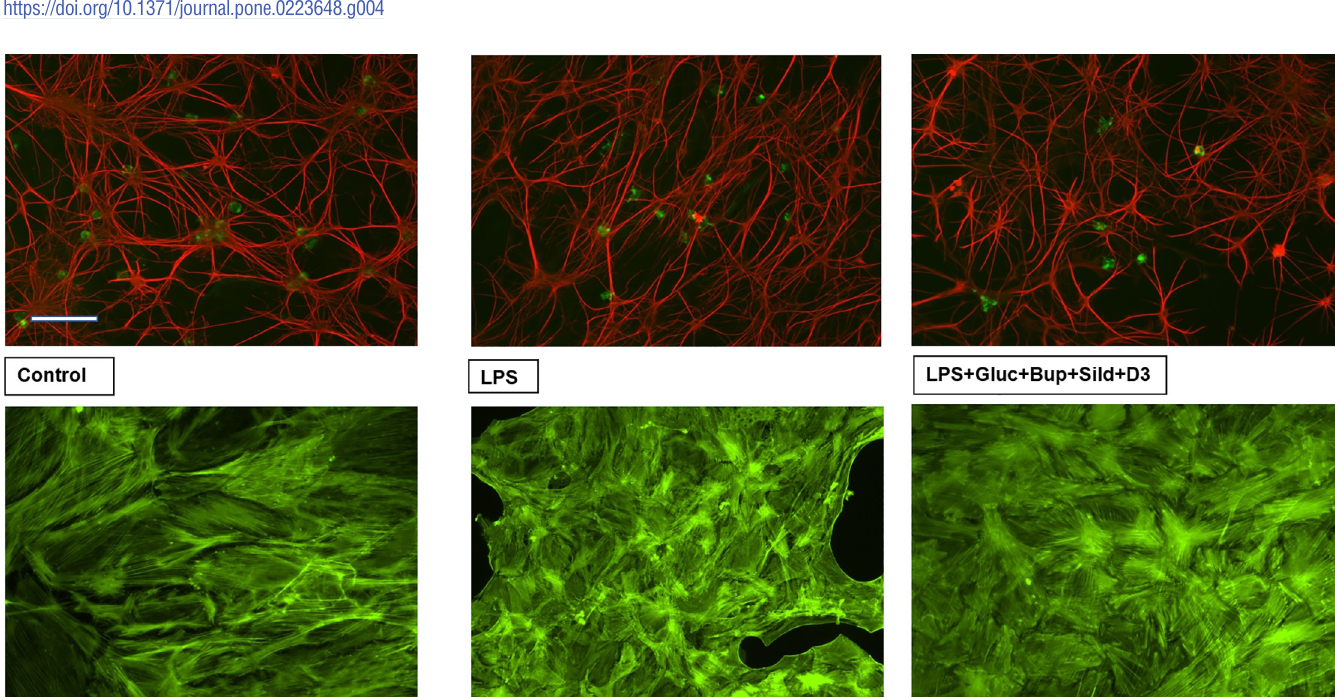
Fig 5. Cultures stained for the astrocytic marker GFAP (red) and the microglial marker OX42 (green), upper figures. Actin filament staining with Alexa488-conjugated phalloidin which shows mainly stress fibers in the control culture and after restoration while cells treated with LPS show a diffuse reorganization of the stress fibers, lower figures. Scale bar = 50 μ m. Representative images are presented. https://doi.org/10.1371/journal.pone.0223648.g005 PLOS ONE | https://doi.org/10.1371/journal.pone.0223648 October 9,